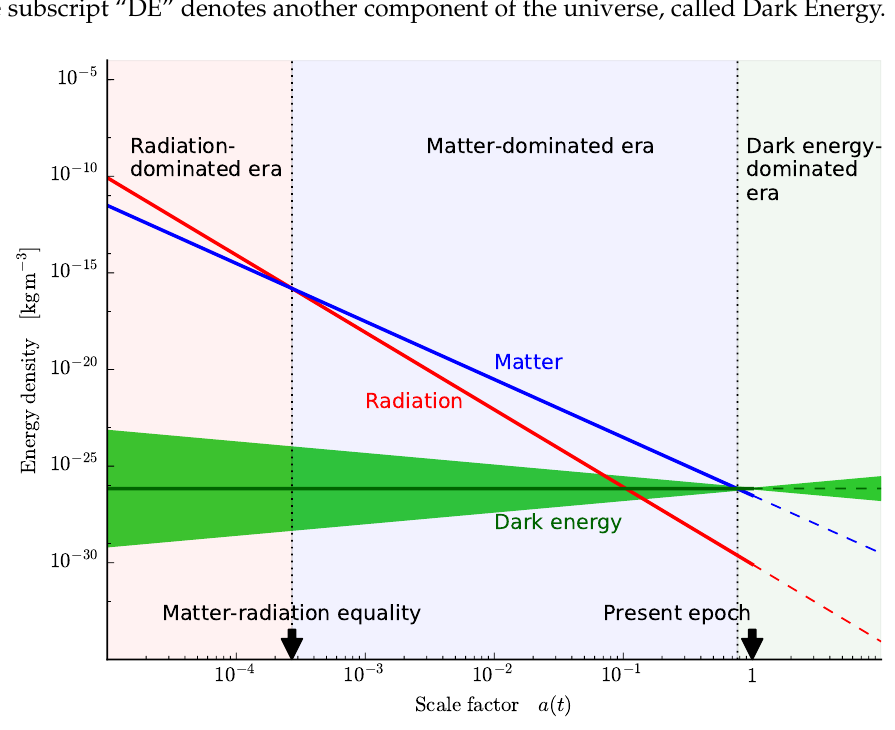
Figure 2. The density evolution of the main components of the universe. The early universe was radiation-dominated, until the temperature dropped enough for matter density to being to dominate. The energy density of dark energy is constant if its equation of state parameter w = 1. Because the matter energy density drops as the scale factor increased, dark energy began to dominate in the recent past. At the present time ( a ( t ) = 1), we live in a universe dominated by dark energy. For dark energy, the green band represents an equation of state parameter w = 1 0.2, showing how a small − ± change in the value of this parameter can give very different evolution histories for dark energy. If the Concordance Model is correct, the universe will be completely dominated by dark energy in future epochs (shown by the dashed lines). The matter density will keep decreasing as the universe expands. Our Milky Way will merge with the Andromeda Galaxy, and eventually, the entire Local Group will coalesce into one galaxy. The luminosities of galaxies will begin to decrease as the stars run out of fuel and the supply of gas for star formation is exhausted. In the very far future, this galaxy will be in the only one in our Hubble patch, as all the other galaxies will pass behind the cosmological horizon. The night sky, save for the stars in the Local Group, will be very dark indeed. Stellar remnants will either escape galaxies or fall into the central supermassive black hole. Eventually, baryonic matter may disappear altogether as all nucleons including protons decay, or all matter may decay into iron. In either scenario, the universe will end up being dominated by black holes, which will evaporate by Hawking radiation. The end result is a Dark Era with an almost empty universe, and the entire universe in an extremely low energy state, with a possible heat death as entropy production ceases (see, e.g., [149,150]) What happens after that is